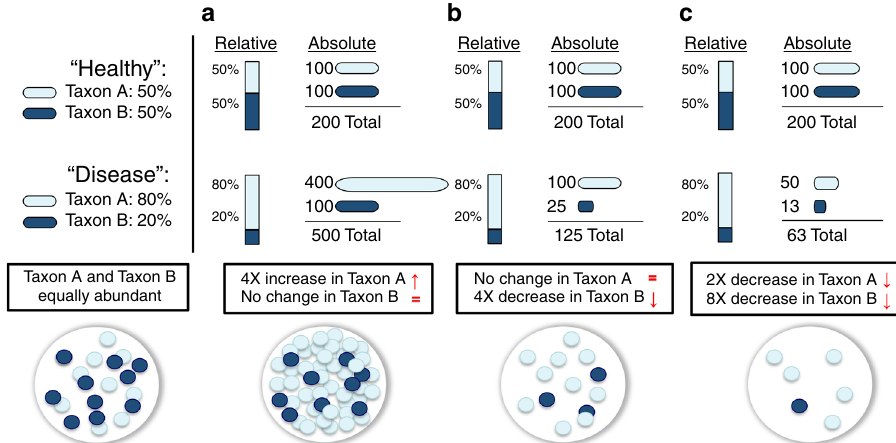
Fig. 1 The value of absolute (compared with relative) quanti fi cation illustrated by three hypothetical scenarios. In this hypothetical, two taxa (Taxon A and Taxon B) are found in equal abundance (50:50) in a “ healthy ” state but in an 80:20 ratio in the “ disease ” state. Three possible scenarios arise: a Taxon A increases in abundance while Taxon B remains the same; b Taxon A remains unchanged while Taxon B decreases in abundance, and c Taxon A and Taxon B both decrease, but Taxon B decreases by a greater